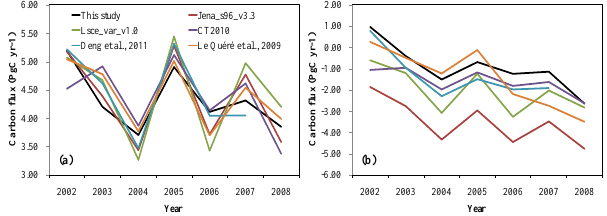
Fig. 6. Inter-annual variations of the terrestrial ecosystem carbon sink in China (2002 - 2008) 850